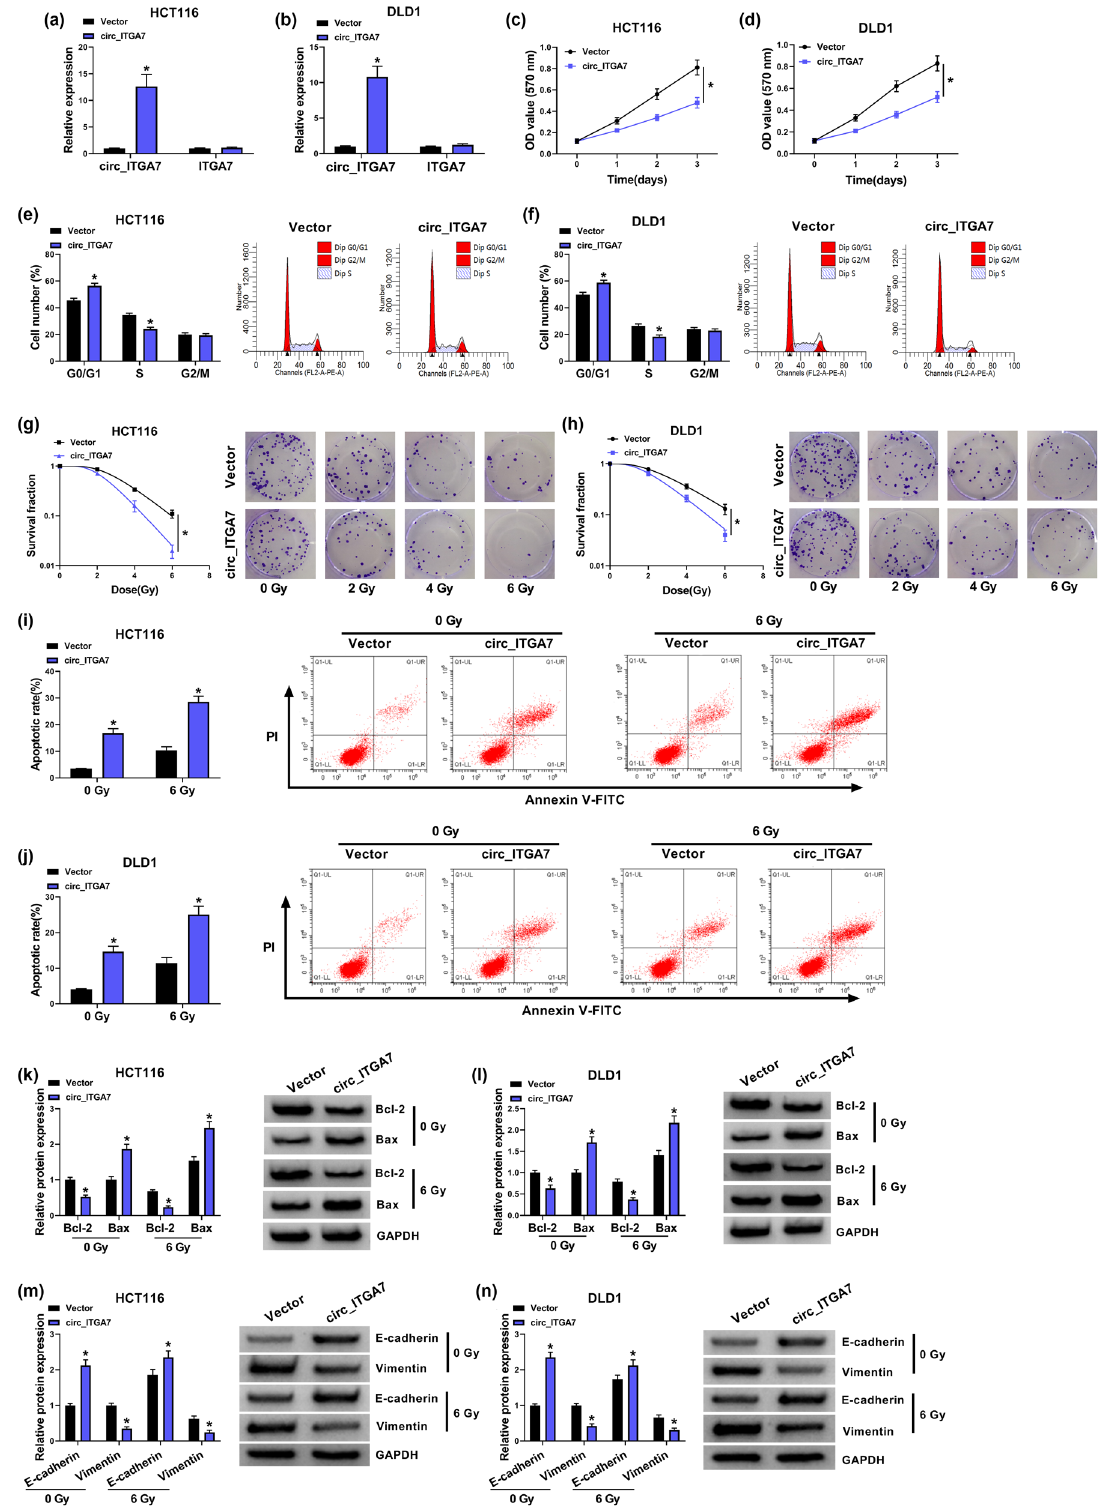
Figure 2: circ_ITGA7 overexpression suppresses cell growth and enhances radiosensitivity in CRC in vitro . ( a – l ) HCT116 and DLD1 cells were transfected with Vector or circ_ITGA7. ( a and b ) qRT - PCR analysis of circ_ITGA7 expression in HCT116 and DLD1 cells. ( c and d ) CCK - 8 assay for the proliferation of HCT116 and DLD1 cells. ( e and f ) Flow cytometry for cell cycle distribution in HCT116 and DLD1 cells. ( g and h ) Colony formation assay for survival fraction in transfected HCT116 and DLD1 cells exposed to various doses of irradiation ( 0, 2, 4, or 6 Gy ) . ( i and j ) Flow cytometry for the apoptosis of transfected HCT116 and DLD1 cells exposed to 0 or 6 Gy irradiation. ( k – n ) Western blot analysis of Bax, Bcl - 2, E - cadherin, and Vimentin protein levels in transfected HCT116 and DLD1 cells exposed to 0 or 6 Gy irradiation. * P <